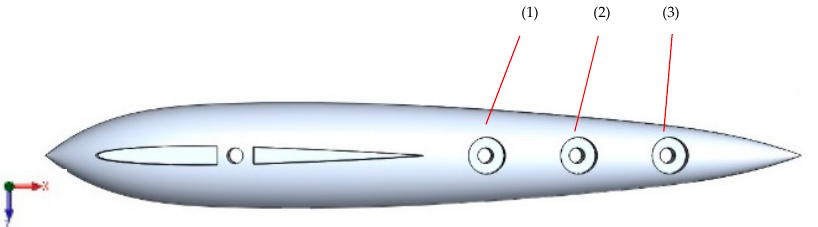
Figure A1. Bolt indexing. (1), (2) and (3), front middle and rear bolt positions. The overall longitudinal length of the component is 290 mm . Table A2. Definitive load cases list.